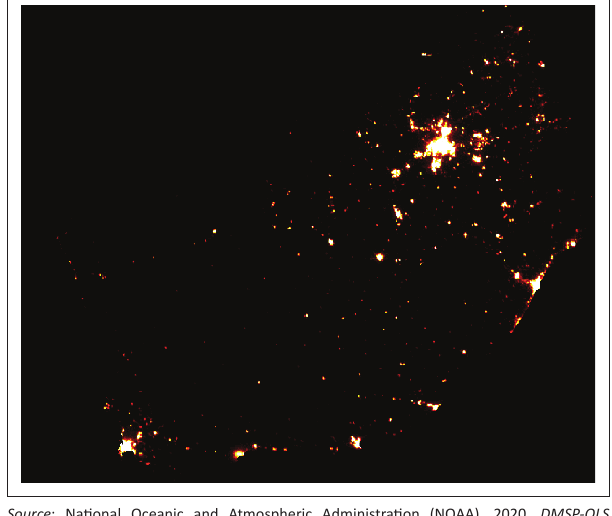
FIGURE 2: Defence Meteorological Satellite Program–Operational Linescan System night-time lights South Africa,